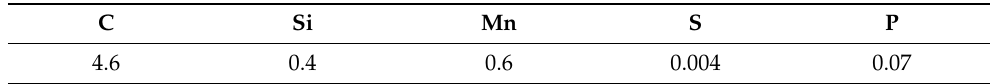
Table 5. HM composition/wt.%.